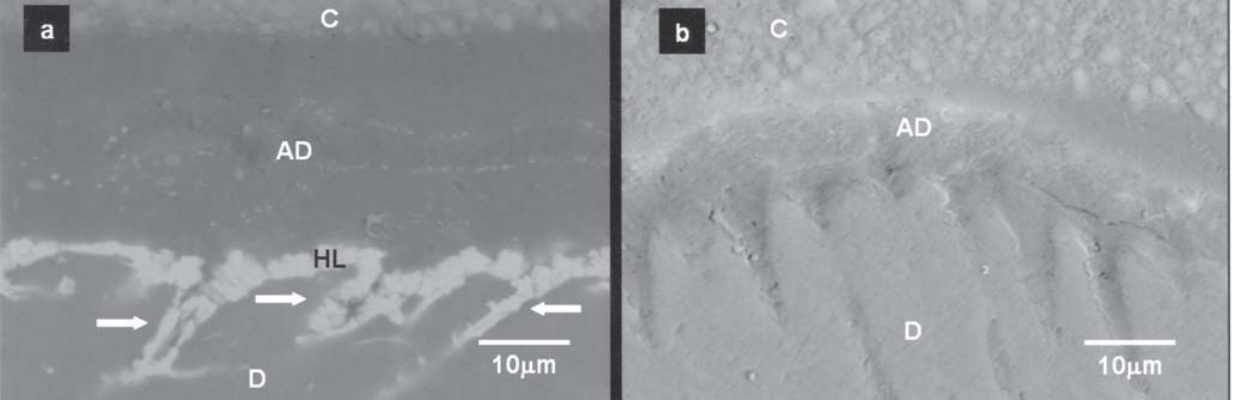
FIGURE 2- Backscattered SEM images of the resin-dentin interface bonded with PB (2500x). In (a), acid-etched specimen. Intense accumulation of silver grains can be observed within the hybrid layer and along the dentin tubules (arrows). In (b), acid-etched specimen treated with NaOCl. No silver deposition could be observed along the interface. (D) dentin; (C) composite resin; (HL) hybrid layer; (AD) adhesive layer